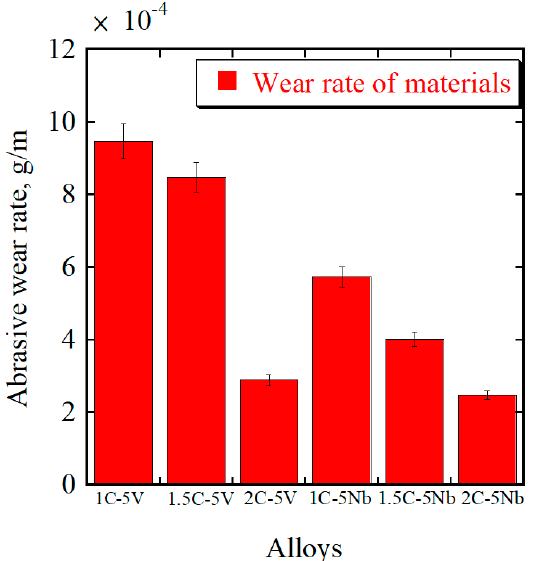
Figure 8. The abrasive wear rates for both alloys with different percentages of C